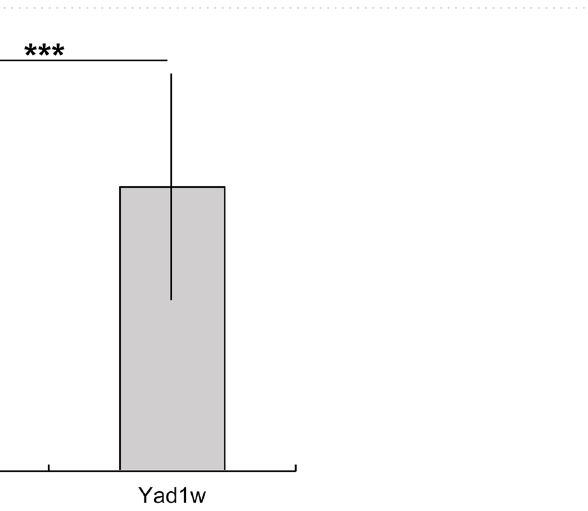
Figure 2. Indirect immunofluorescence micrographs of alga-free P. bursaria strain Yad1w cell ( a )–( b’ ) and algae-bearing P. bursaria strain Yad1g1N cell in ( c )–( e’ ). ( a ) and ( c ): DIC micrographs. ( b ) and ( d ): Images of immunofluorescence of goat anti-mouse IgG. ( b’ ) Enlargement the host cell cortex in ( b ). ( e ) A merged image of ( d ) and the autofluorescence of chlorophyll in algal chloroplasts. ( e’ ) The enlargement of some symbiotic algae near the host cell cortex in ( e ). Note that the host mitochondria are localized around the symbiotic algae ( e’ ). Immunofluorescence shows that the mitochondria of the cell cortex of the alga-free cells are more numerous ( b’ ) than those of algae-bearing cells ( e’ ). Ma, macronucleus. Bar = 20 μm ( a , b , c , d , and e ) and 5 μm ( b’ and e’ ).